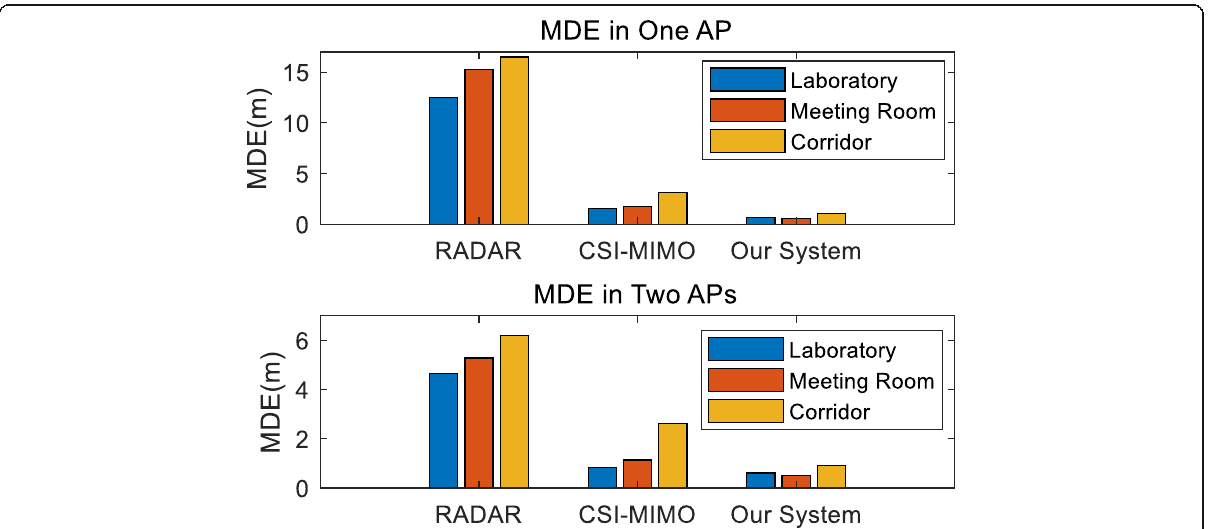
Fig. 12 Comparison with other localization system. In the top figure, blue, red, and orange bar represent the median distance error of different localization system with one AP in the laboratory, meeting room, and the corridor, respectively. In the top figure, blue, red, and orange bar represent the median distance error of different localization system with two AP in the laboratory, meeting room and the corridor,